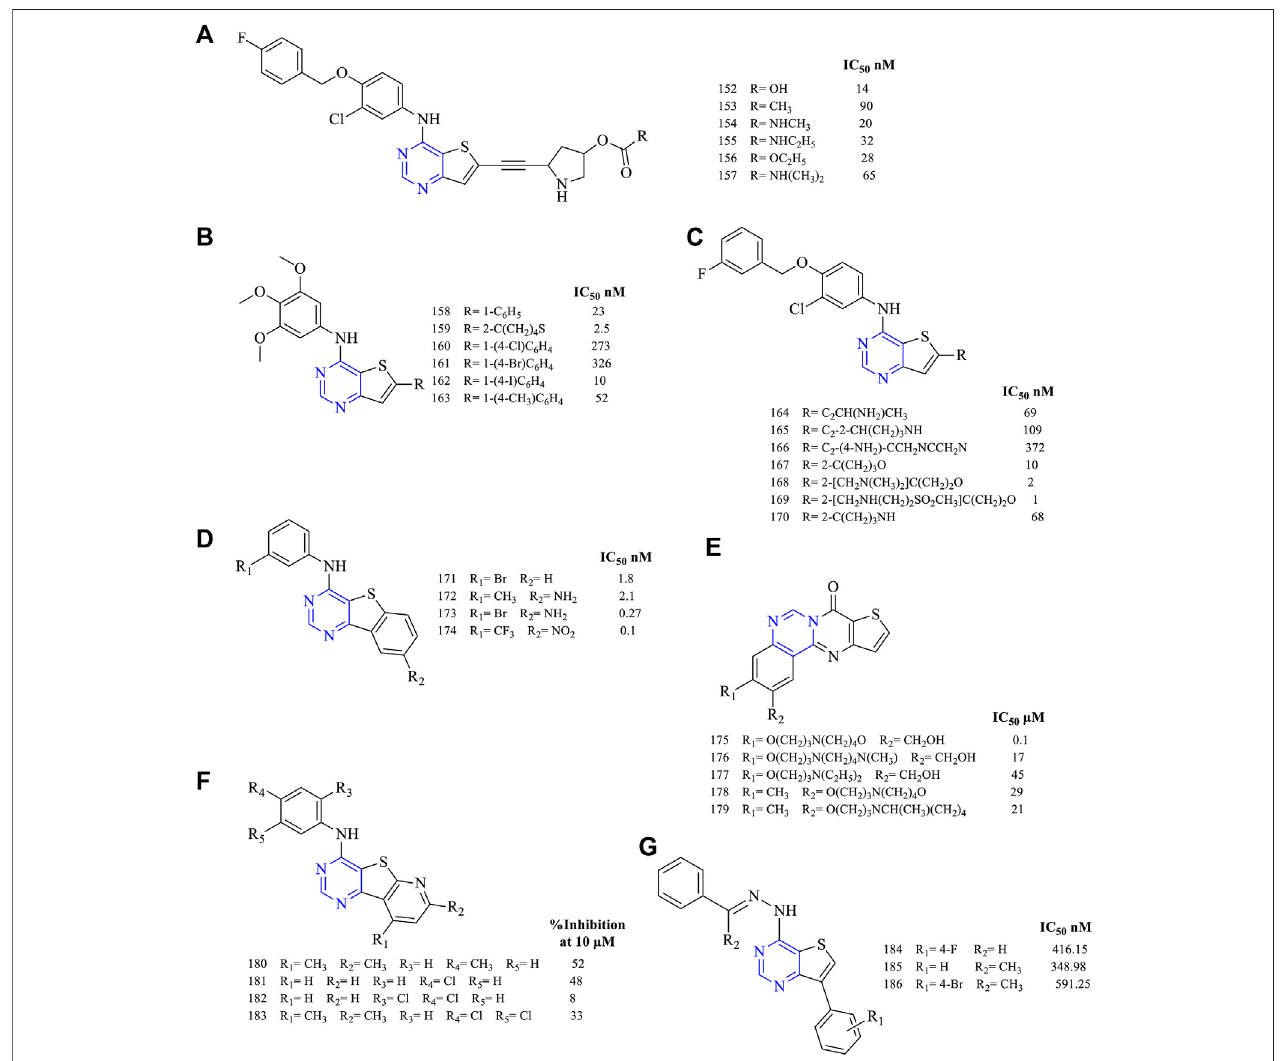
( Figure 12H ) (EGFR IC 50 0.07 µM for 146 , 0.042 µM for 147 , 0.07 µM for 148, 0.028 µM for 149 , 0.2 µM for 150, and 0.46